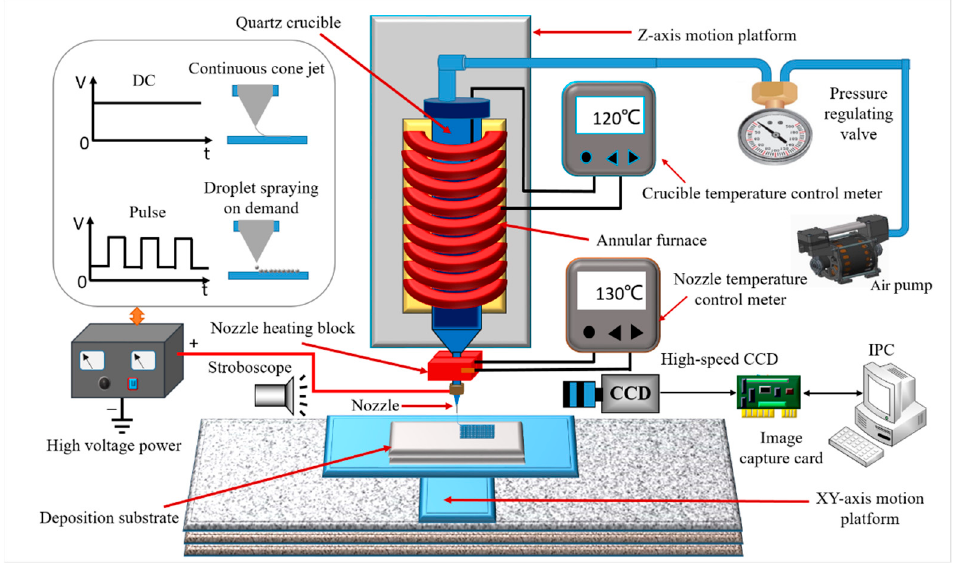
Figure 2. Schematic diagram of EFD jet deposition 3D printing experimental system.